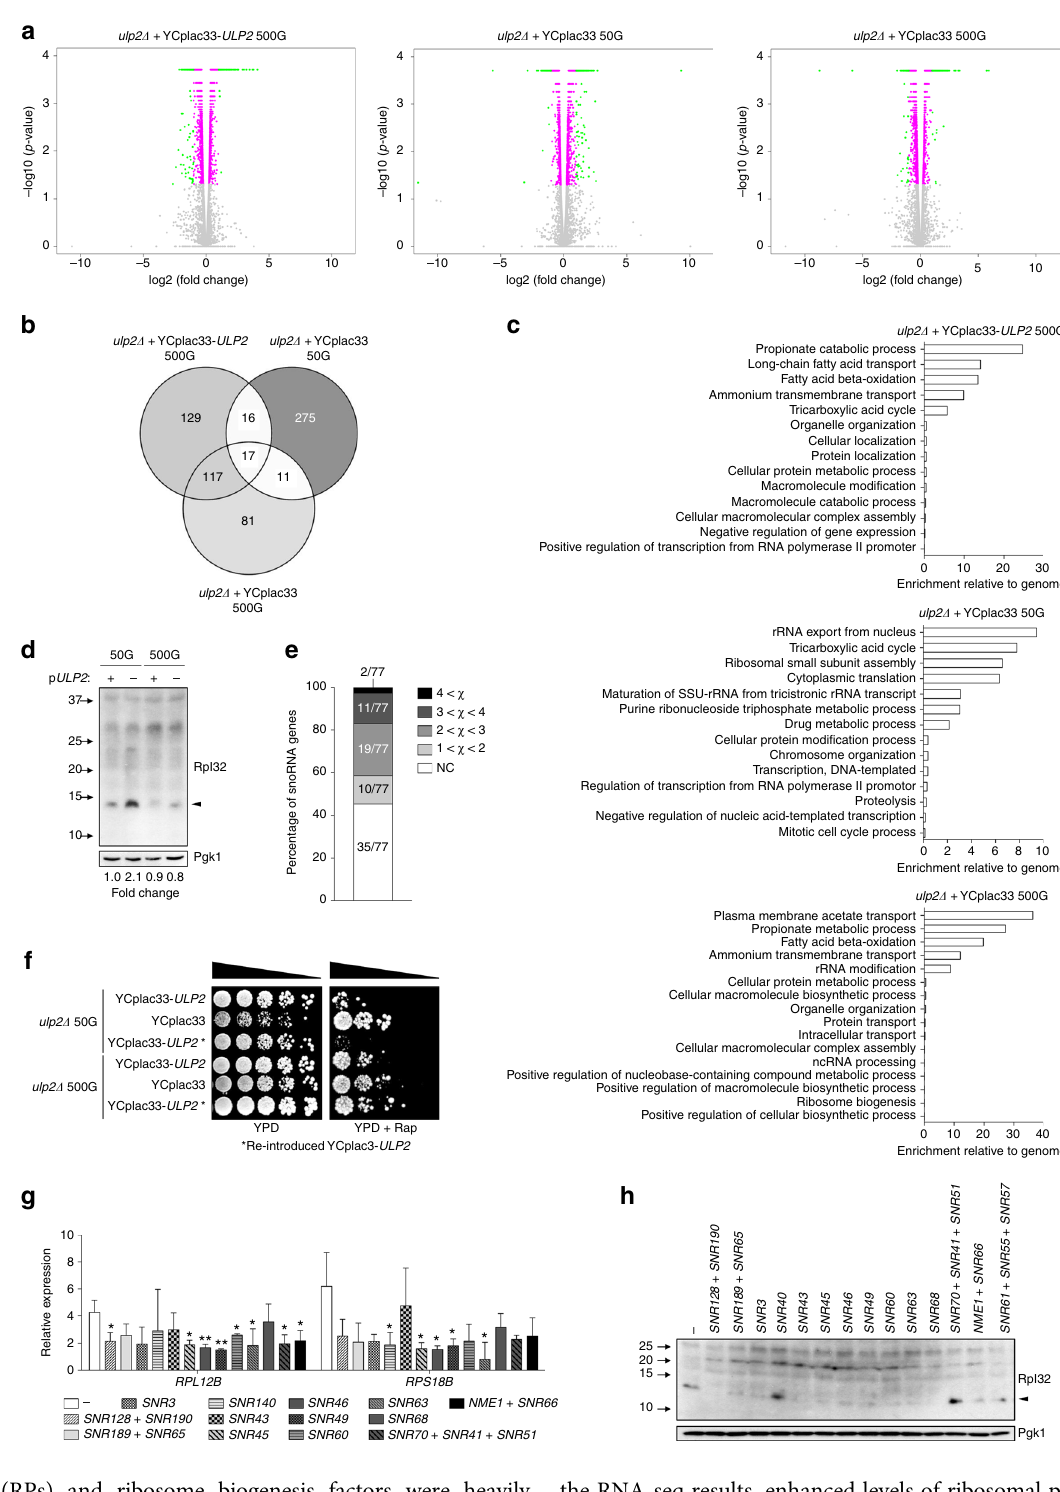
the RNA-seq results, enhanced levels of ribosomal protein Rpl32 in nascent ulp2 Δ cells were observed, and this returned to control levels after 500 generations. (Fig. 2d). Earlier genome-wide analysis of SUMO modi fi cations in yeast revealed that SUMO preferentially localizes to genes involved in translation, such as tRNA and RP genes 28 , and both RPs and ribosome biogenesis factors undergo SUMOylation 29 . Interest- ingly, sumoylation of the Rap1 transcription factor cooperates with the target of rapamycin complex 1 (TORC1) kinase pathway to promote transcription of genes encoding RPs 28 . We